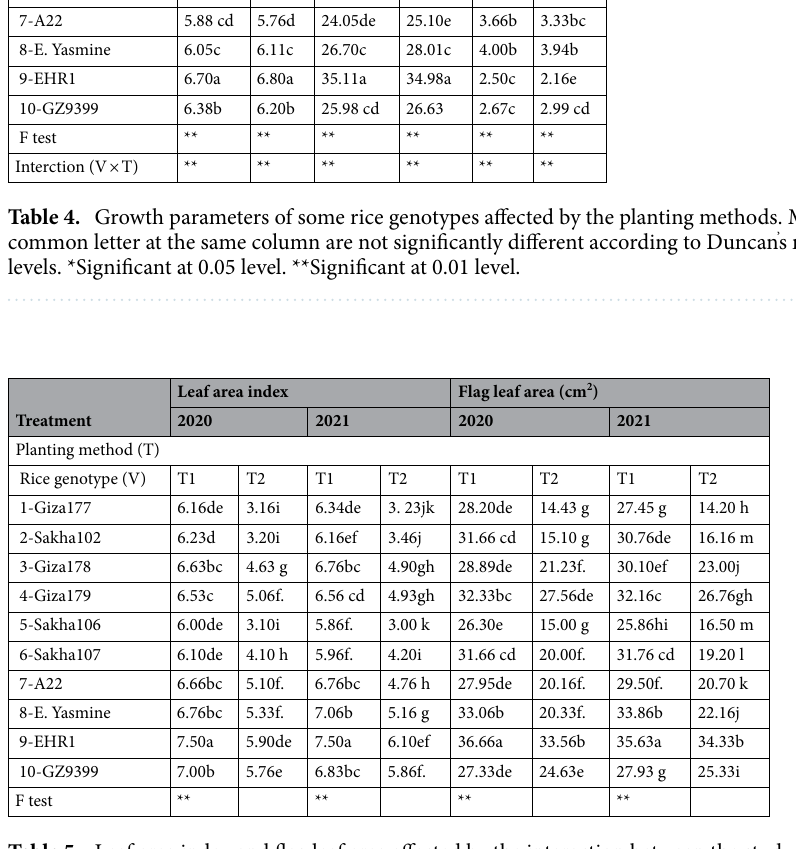
Table 5. Leaf area index and flag leaf area affected by the interaction between the study factors. T1 = Transplanting, T2 = Aerobic, **Significant at 0.01 level. Means followed by a common letter at the same column are not significantly different according to Duncan ’ s multiple range at 0.05